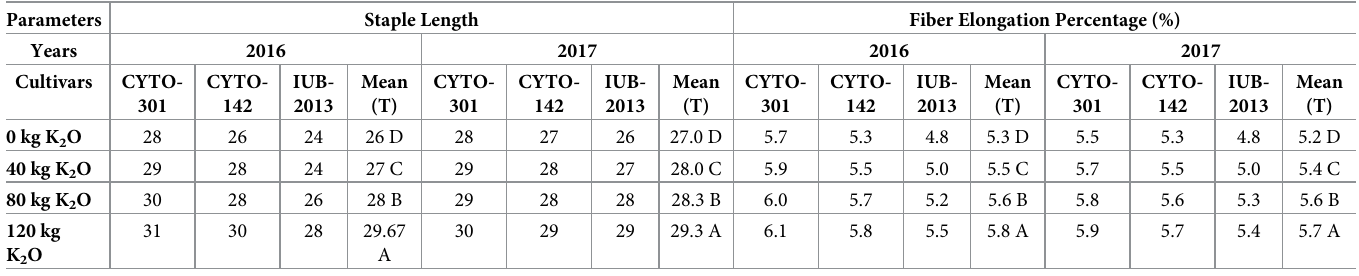
C = Cultivars, T = Treatments, NS = Non-significant, Different alphabets with in the same column or row indicate statistically significant differences.